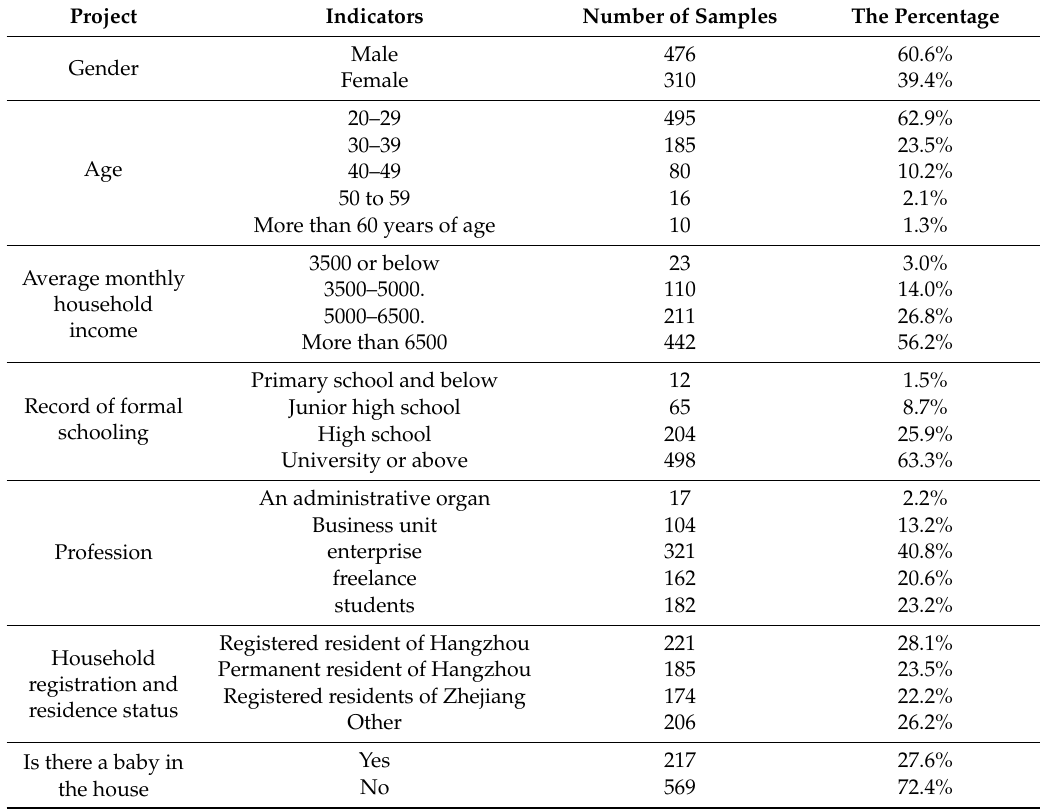
Table 2. General descriptive